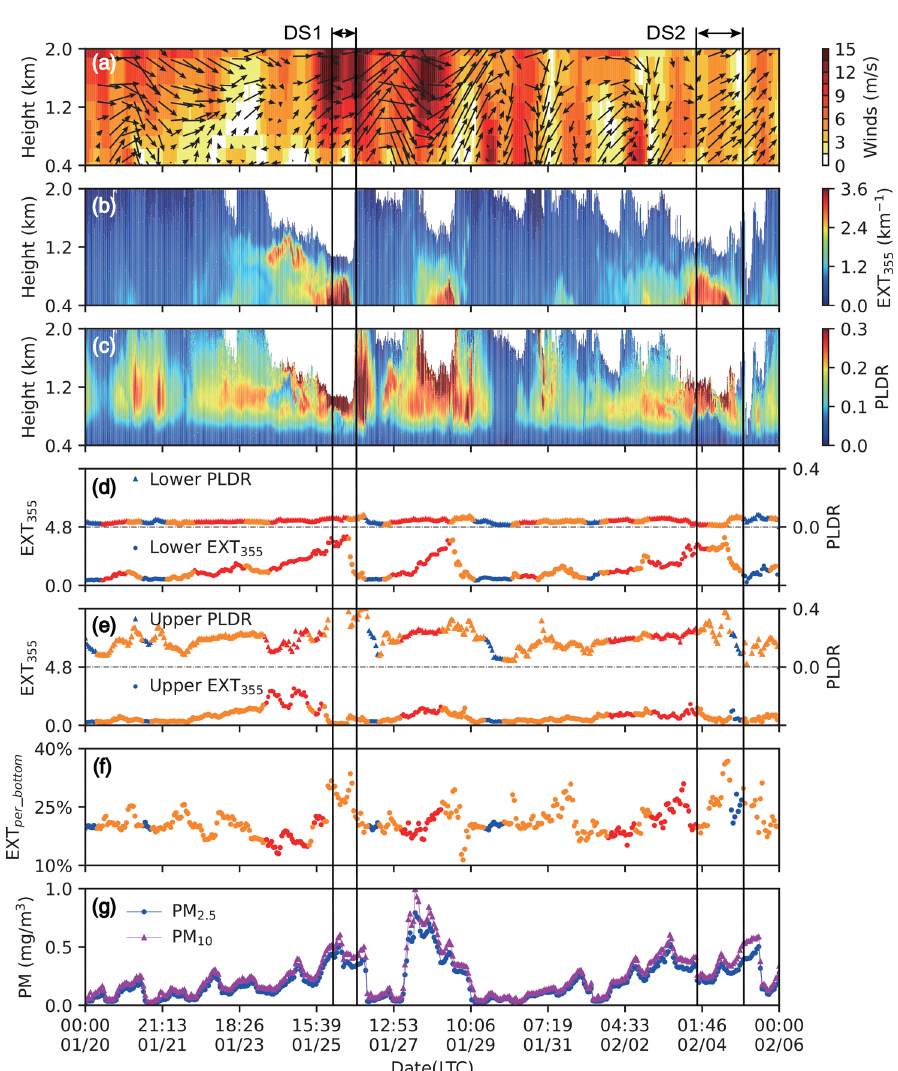
Figure 2. Periodic air pollution cycles in North China. The colored contours show the vertical structure of (a) horizontal winds simulated by WRF-Chem, (b) EXT 355 , and (c) the PLDR measured by RL. Temporal evolutions of spatially averaged PLDR and EXT 355 at (d) 450– 550m and (e) 950–1050m. (f) The percentage of bottom EXT 355 . (g) Temporal evolutions of surface average PM 2 . 5 and PM 10 mass concentrations. The black arrow in (a) indicates the wind direction; the upper arrow is for south winds. The colors in (d) , (e) , and (f) represent the air masses originating from southwest (red), Gobi desert (yellow), and sparsely populated northern mountain areas (blue), similar to those in Fig. S1. The observed PM 2 . 5 and PM 10 mass concentrations are the averages of the six environmental monitoring stations in Baoding. The percentage of bottom EXT 355 is used to characterize the aerosol concentrations in the lower layer, which is defined as 600 1000 (cid:80) (cid:80) EXT per_bottom = 100% × EXT 355 (z)/ EXT 355 (z) , where EXT per_bottom is the percentage of bottom EXT 355 and z is the z = 400 z = 400